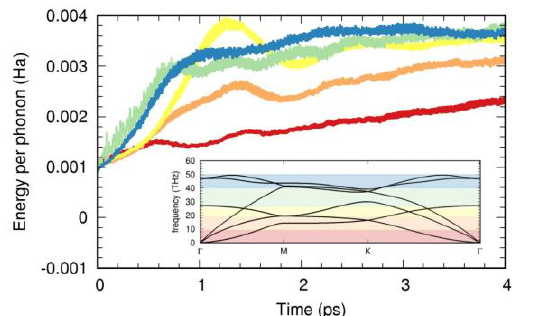
Fig. 2. The time-evolution of the Phonon energies averaged over 20 runs and sets of phonon modes (see description) after ultrafast laser excitation in graphene. The inset shows the phonon dispersion of graphene, where the used sets of phonon modes are indicated by the